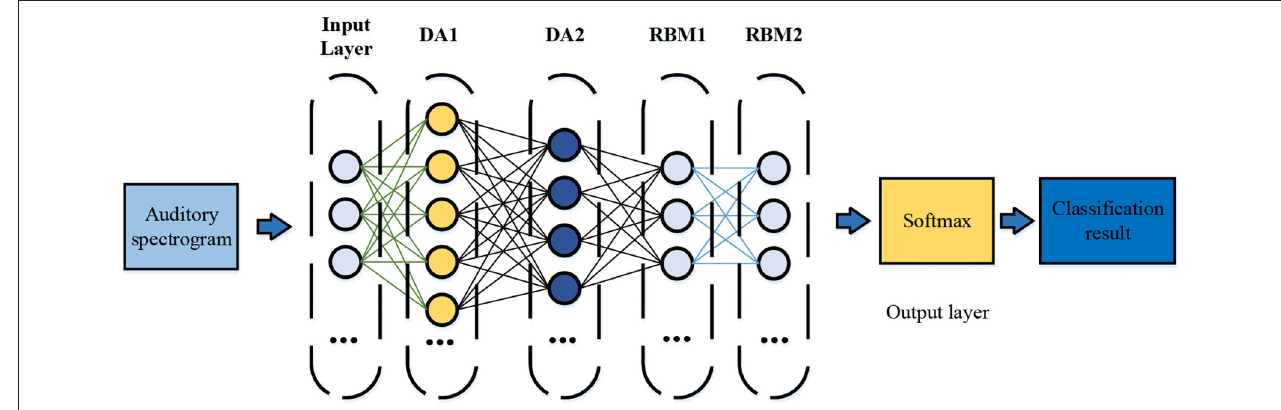
FIGURE 2 | Hybrid Neural Network (HNN) structure of musical instrument recognition.